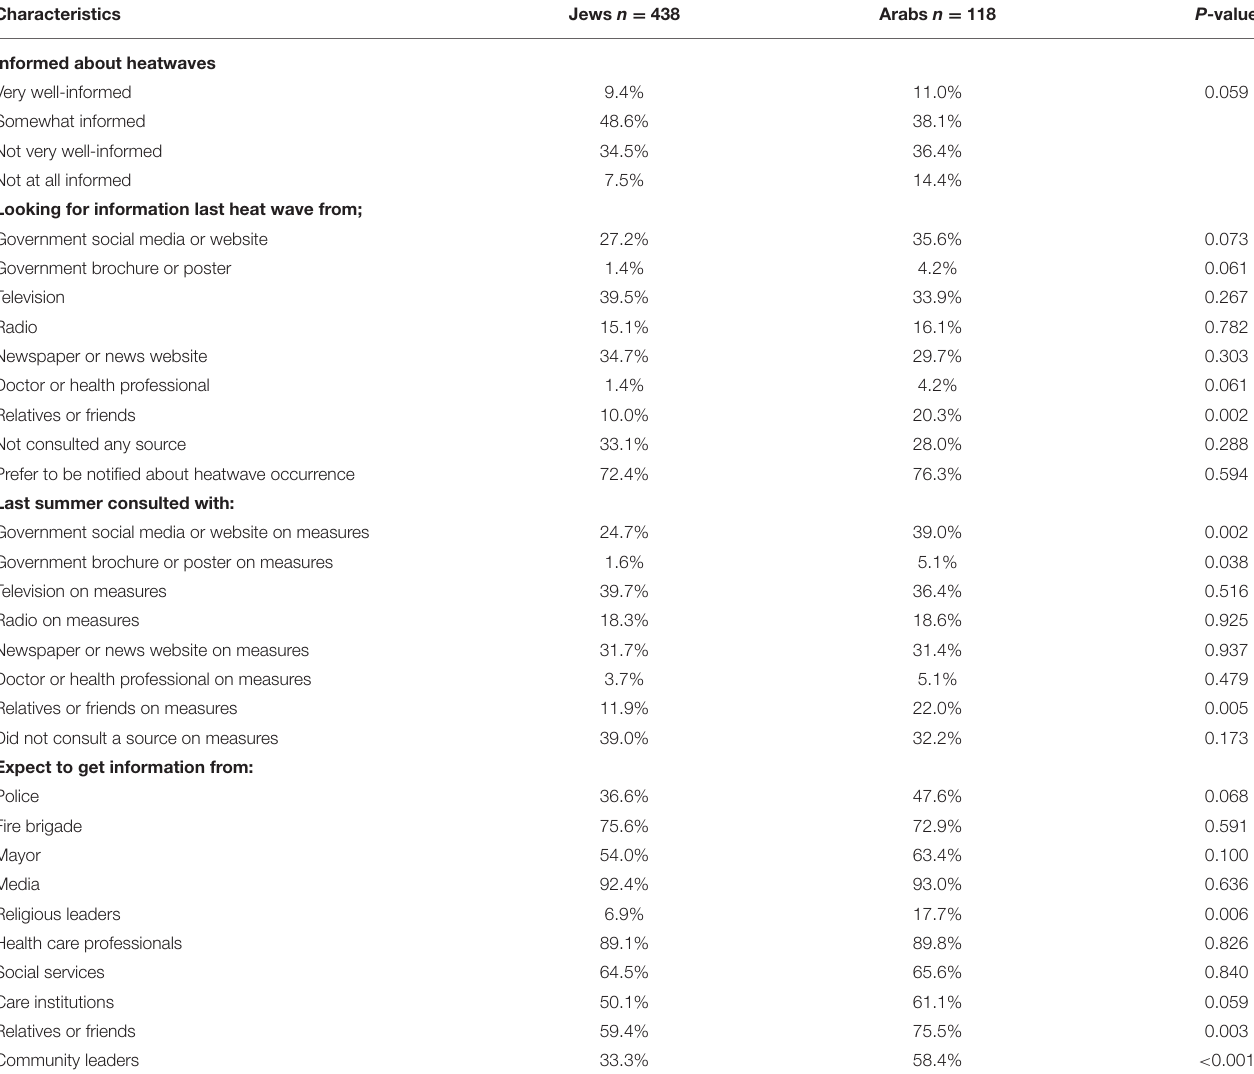
TABLE 3 | Differences in information